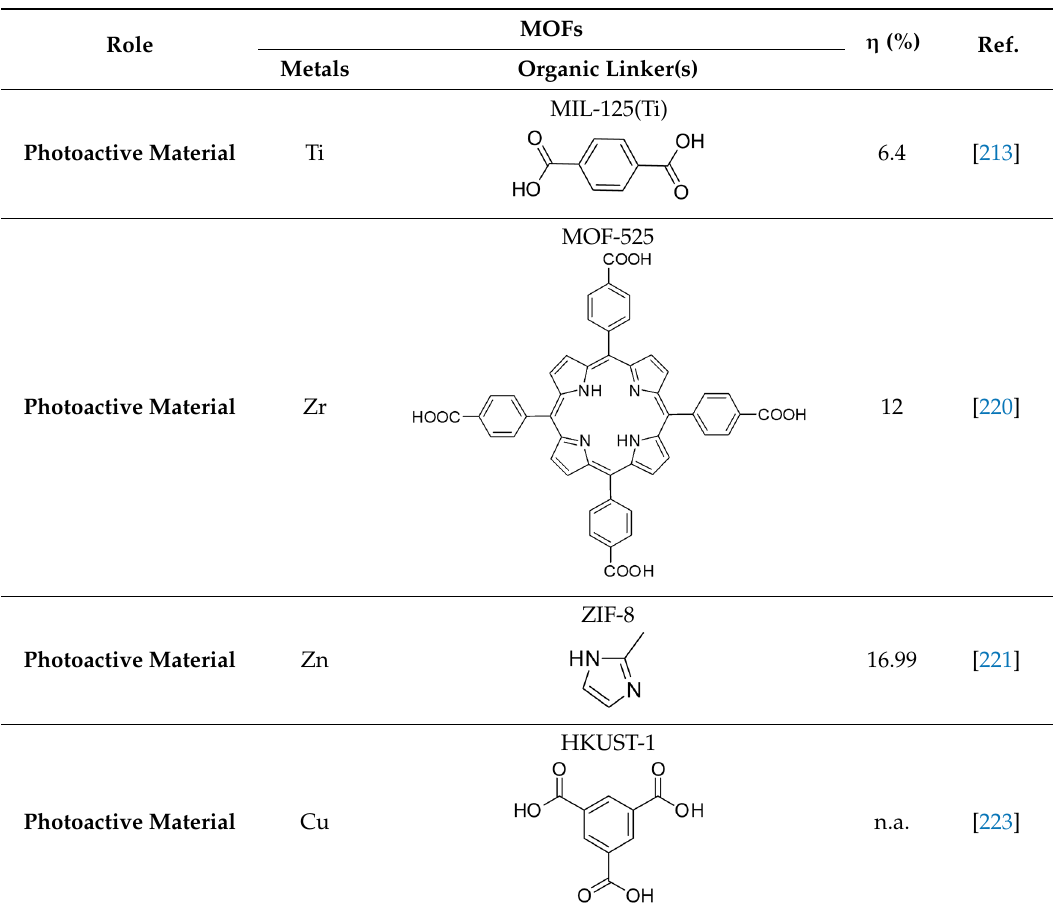
Table 5. Metal ‐ organic frameworks implemented in perovskite solar cells. For sake of brevity, we prefer to report the metal and the organic linker separately. The reported values of photoconversion efficiency could not be compared between each ‐ others, yet they could shine light on the potentiality of this class of material. The main role of the MOF is bold in the first column.